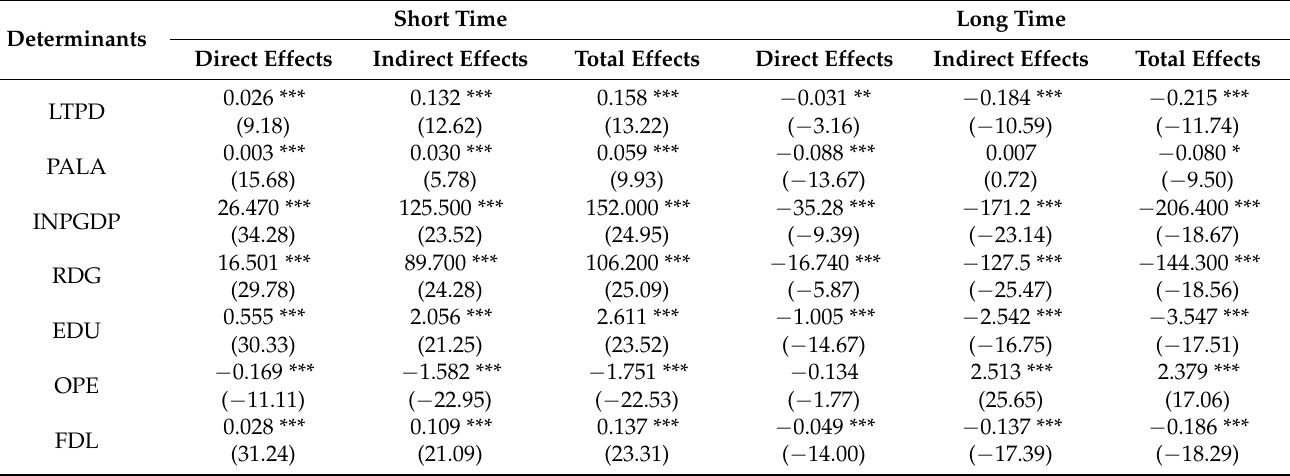
Table 5. Coefficients of spatial effects’ decomposition of the